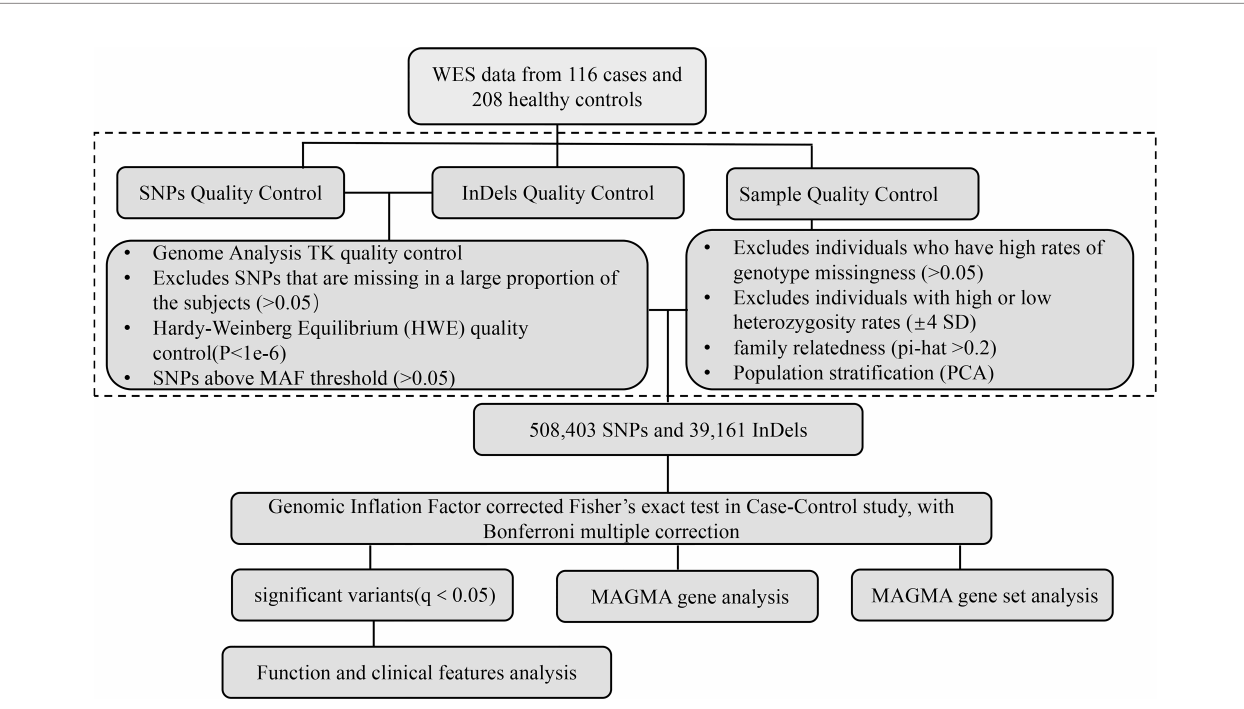
FIGURE 1 | Analytical strategy work fl ow for variant fi ltration and candidate gene selection. A schematic overview of the steps involved in whole-exome sequencing analysis with pathogenesis candidate gene detection is shown. SNPs, single nucleotide polymorphisms; InDels, insertions and deletions; WES, whole-exome sequencing; MAF, minor allele frequency; MAGMA, Multimarker Analysis on GenoMic